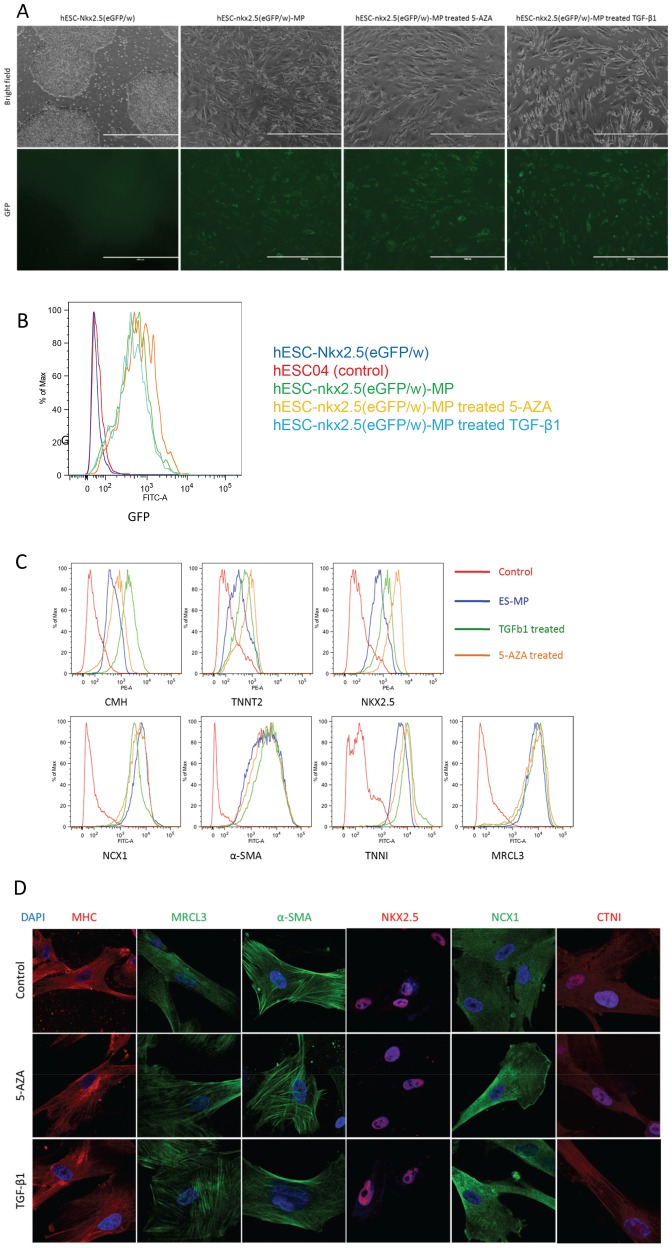
Cardiac marker expression on hESC-MPs and 5-AZA or TGF-β1 treated cells.A. Phase contrast microscopy of hESC-NKX2.5 cell line submitted to our MP derivation protocol demonstrating GFP expression reporting NKX2.5 in our MPs. 5-AZA and TGF-β1 treatments do not modify the GFP expression (last two panels). B. Overlay representing GFP expression (reporting NKX2.5) at day 30 of treatment by 5-AZA or TGF-β1. C. Overlay representing flow cytometry analysis of cardiac myosin heavy chain (CMH), Cardiac Troponin T (CTNT), Homeobox protein NKX2.5, The sodium-calcium exchanger (NCX1), alpha smooth muscle actin (α-SMA), Cardiac Troponin I (CTNI) and Myosin regulatory light chain (MRCL3) in hES-MPs untreated or treated for 30 days by 5-AZA or TGF-β1. D. Confocal microscopy imaging of the expression of cardiac marker genes. MHC, MRCL3, αSMA demonstrate a striated pattern. CTNI demonstrated a weak striated pattern. NKX2.5 is clearly labeled in the nucleus. (x 600).